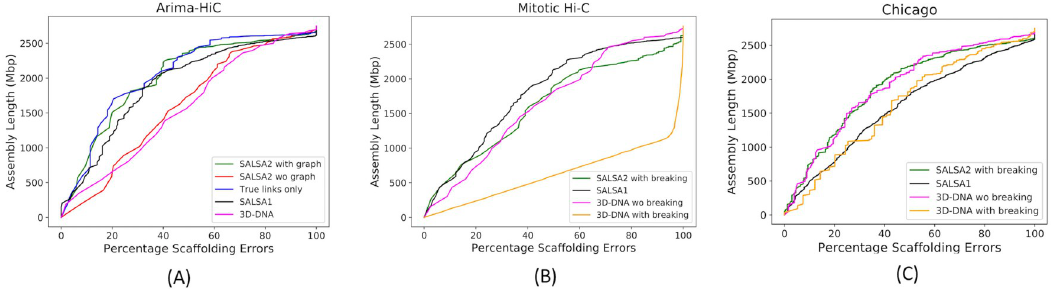
Fig 5. Feature response curve for (A) assemblies obtained from contigs as input (B) assemblies obtained from mitotic Hi-C data and (C) assemblies obtained using Dovetail Chicago data. The best assemblies lie near the top left of the plot, with the largest area under the